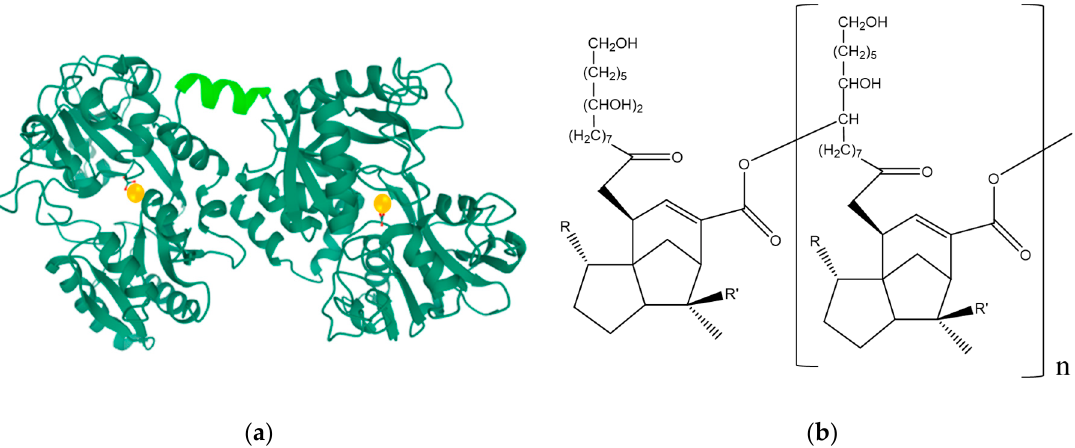
Figure 1. ( a ) Crystal structure of diferric bovine lactoferrin, Lf, MW ~80 kDa (PDB entry 1BLF). The N-lobe and C-lobe connecting α -helix is highlighted in light green (aa. 334–344), and the ferric irons are depicted as orange spheres; and ( b ) Chemical structure of shellac, MW ~586.7 g/mol.